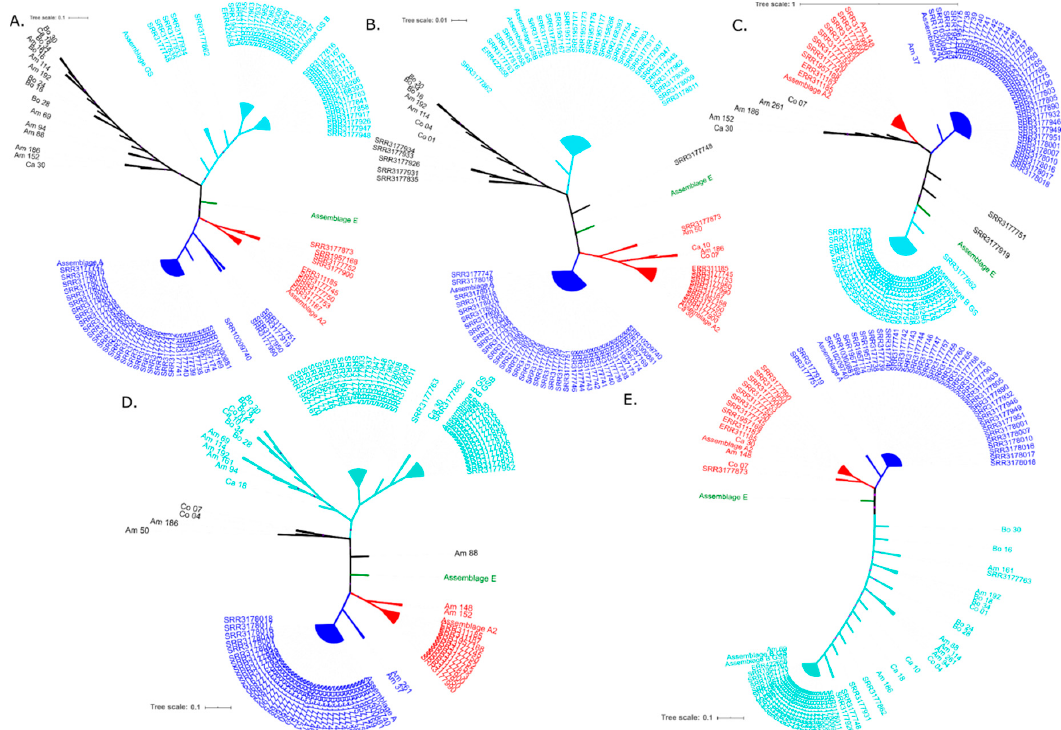
Figure 4. Gene trees including sequences obtained from human faeces as well as sequences extracted from public genomes. (A) ACS . (B) Enolase . (C) SPT . (D) GDH . (E) TPI . Phylogenetic inferences were constructed using maximum likelihood (ML) under the Jukes Cantor nucleotide evolution model, with 1000 bootstrap iterations. The tree was constructed with FastTree [45] software and